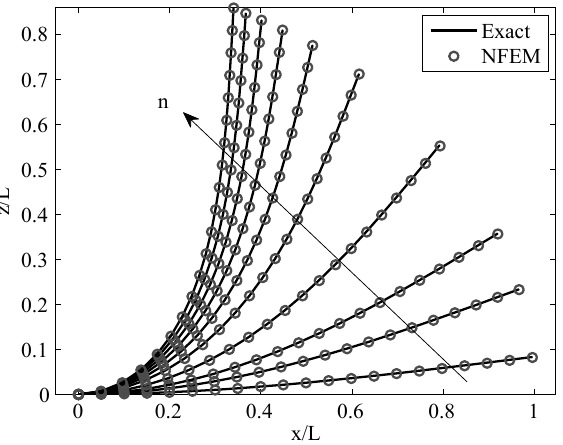
2 EI n = [0.1, 0.3, 0.5, 1,2, 3, 4 L 2 and